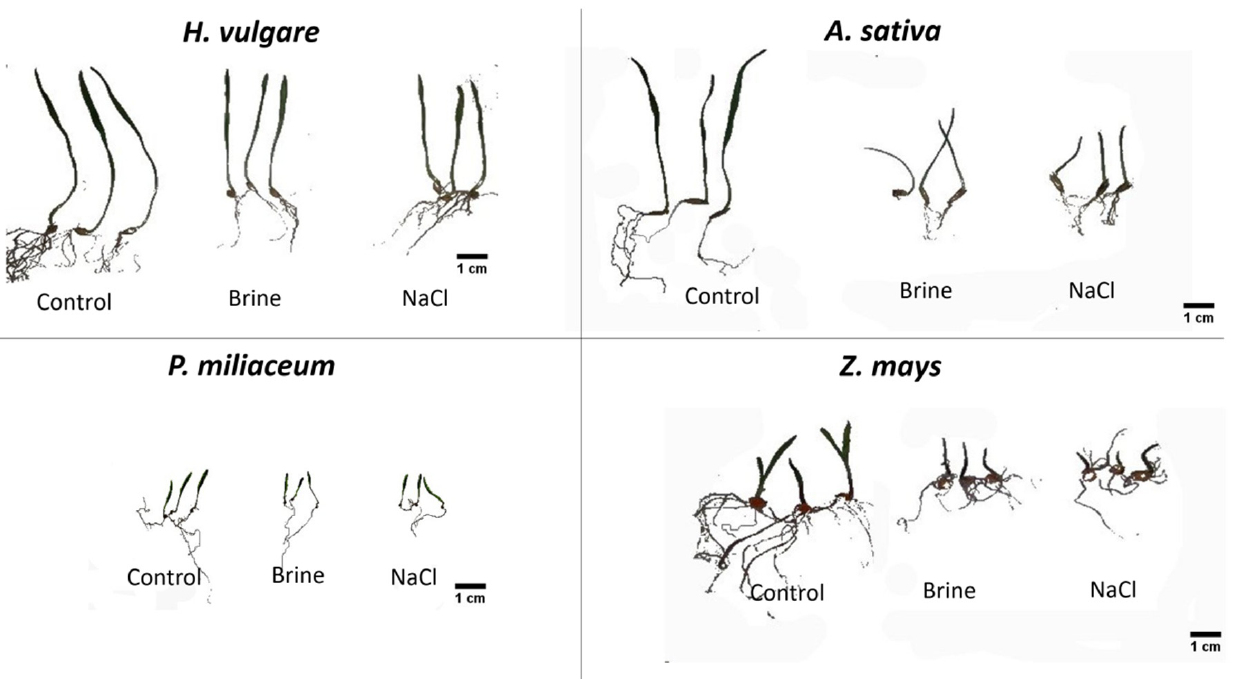
Figure 2. Growth of seven-day-old seedlings in control, brine and NaCl solutions. Only three individuals of each treatment are shown. Table 1. Osmotic and ionic composition effects on seedlings of model plants after seven days of